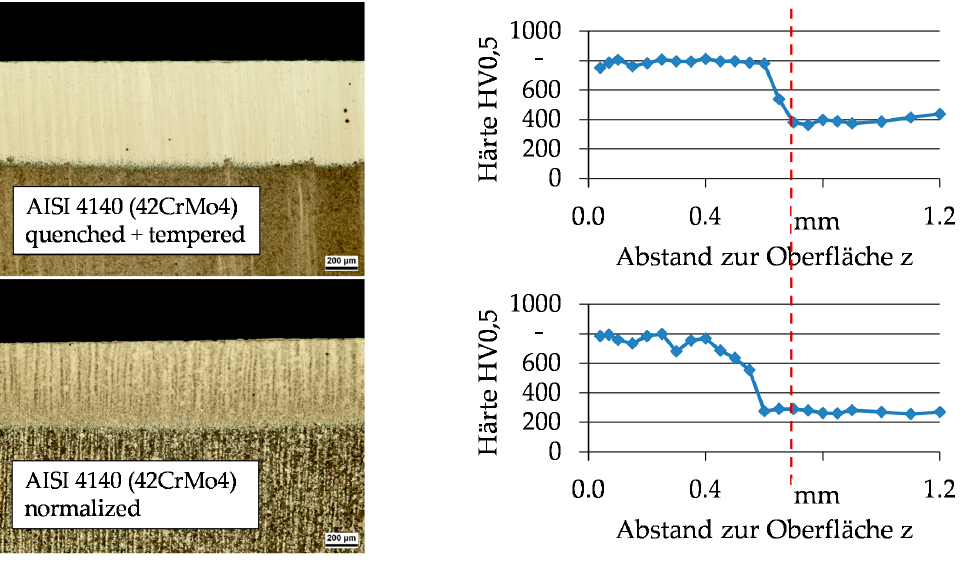
Figure 2. The microstructure of AISI 4140 for the quenched and tempered (QT) state and the normalized state after surface-grin-hardening ( left ), and the corresponding hardness depth profiles ( right ) (a e = 0.5 mm, v ft = 1.2 m/min).